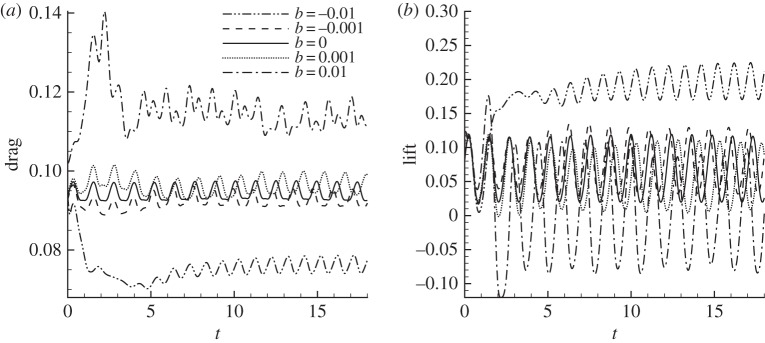
Three-dimensional control effects on (a) drag and (b) lift at Re=2000 and α=10°. The control is imposed around the upper leading edge in the form of blowing (positive b) or suction (negative b).